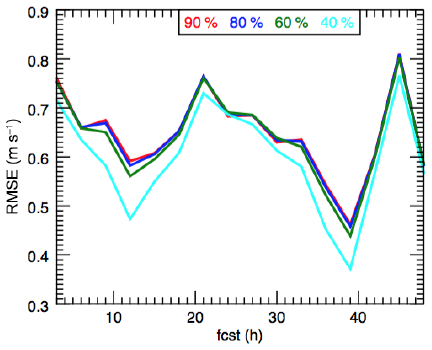
Figure 7. Difference between the RMSE (best model minus TME) of the winter wind speed forecast for different percentages of train- ing